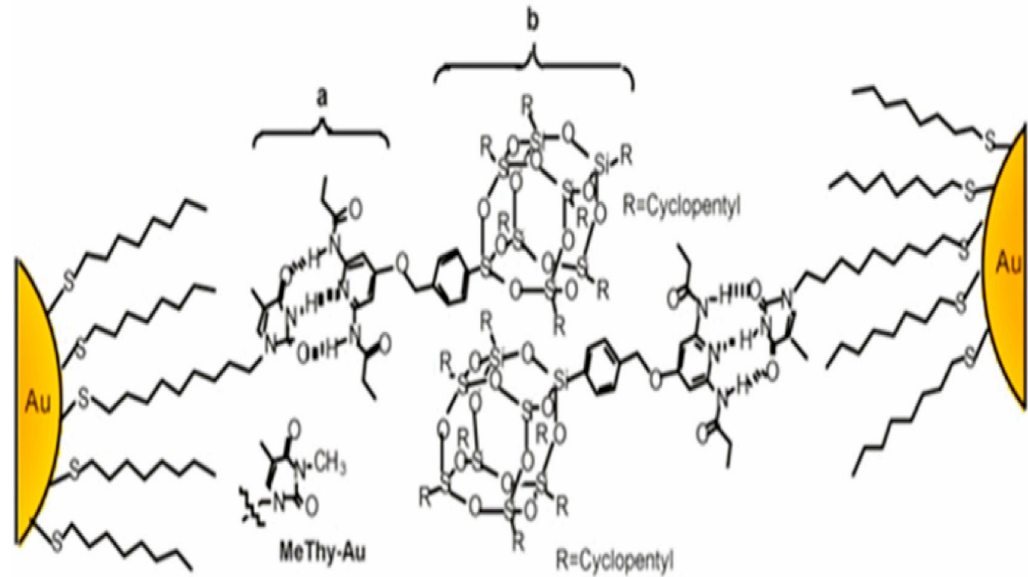
Figure 5. The interaction of Au NPs functionalized via thymine via three-point H 2 bonding ( a ) and the POSS clusters ( b ). Reproduced with reference authorization [59], RSC,